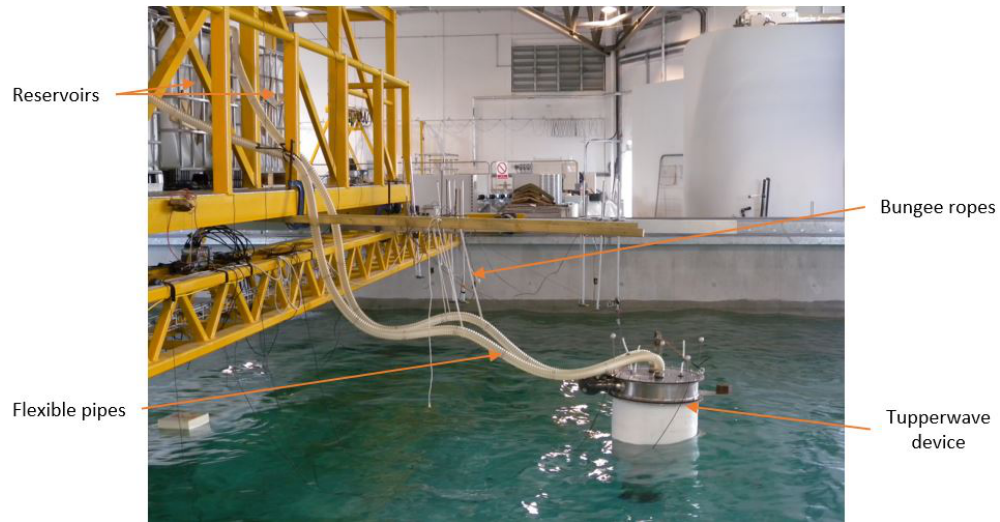
Figure 5. Physical model of the Tupperwave device.